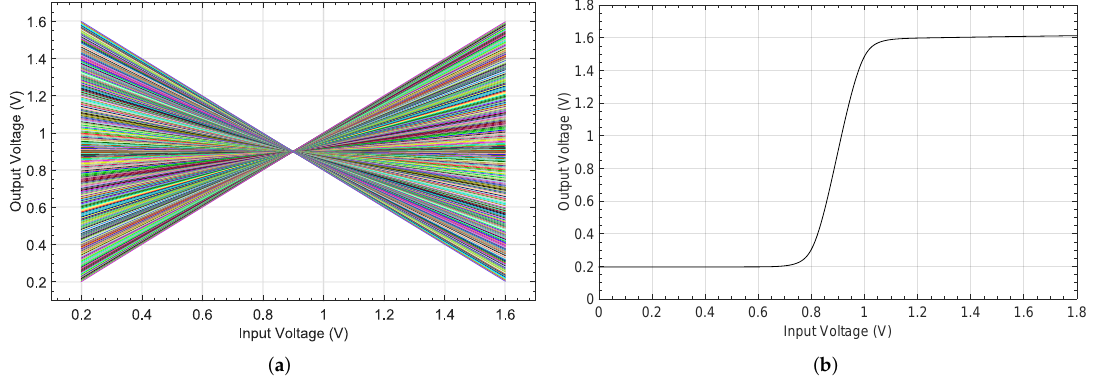
Figure 5. Electrical response for the: ( a ) multiplier and ( b ) activation function